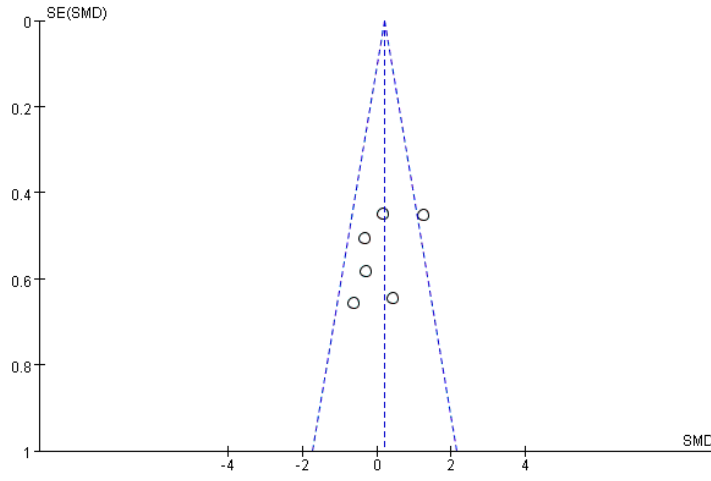
Figure 17. Funnel plot of studies evaluating the anti-fungal activity of S. crispa.